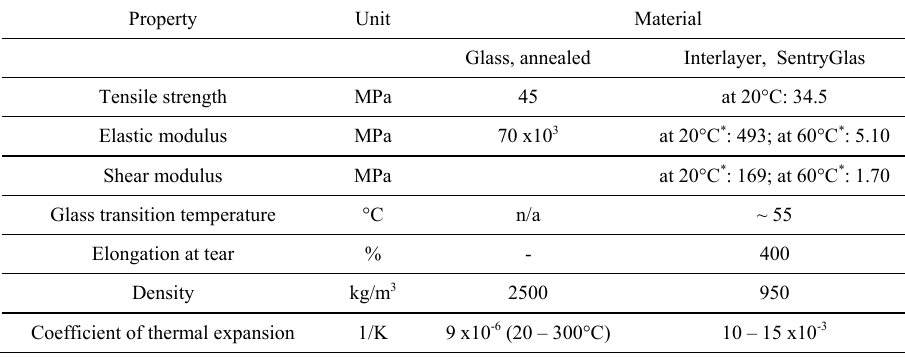
Table 2: Material properties of annealed glass [8] and SentryGlas interlayer material [2, 9]. Property Unit Material Glass, annealed Interlayer, SentryGlas Tensile strength MPa 45 at 20°C: 34.5 Elastic modulus MPa 70 x10 3 at 20°C * : 493; at 60°C * : 5.10 Shear modulus MPa at 20°C * : 169; at 60°C * : 1.70